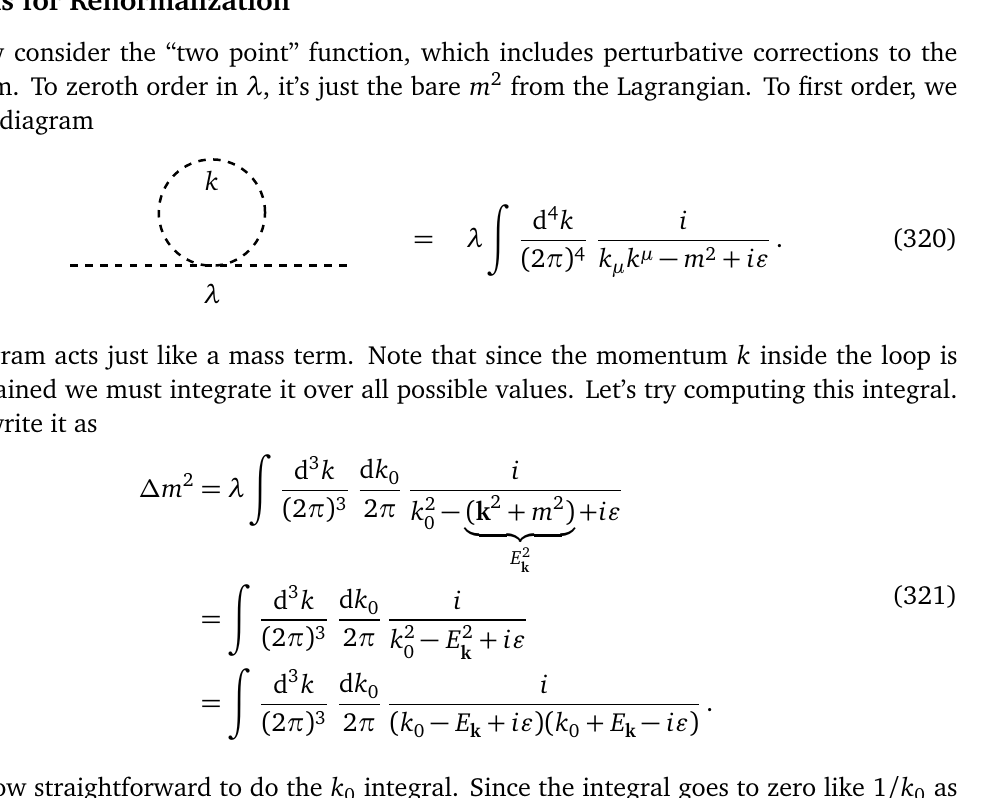
plane, and the poles of 0